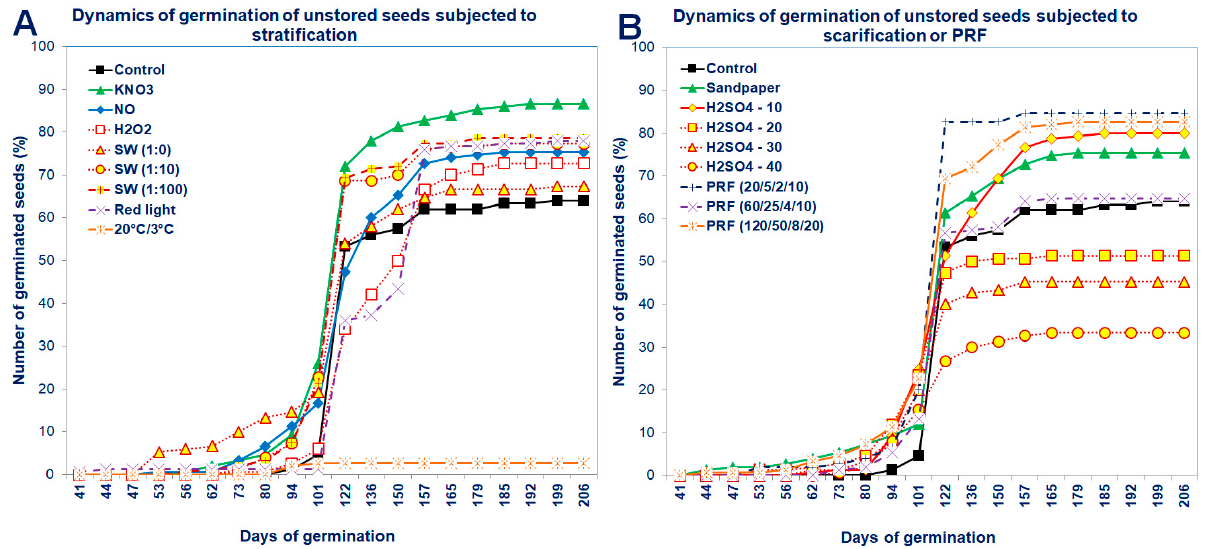
Figure 3. Dynamics of germination of the unstored Saskatoon berry seeds subjected to ( A ) stratification (3 °C) in the presence of KNO 3 , NO, H 2 O 2 , smoke-water (SW, in concentrations of 1:1, 1:10, 1:100) and 20 °C/3 °C or ( B ) scarification: sandpaper, sulfuric acid for 10, 20, 30 and 40 min or treatments with red light or pulsed radio frequency (PRF; 20/5/2/10; 60/25/4/10; 120/50/8/20). Values are the means of three replications of 50 seeds.